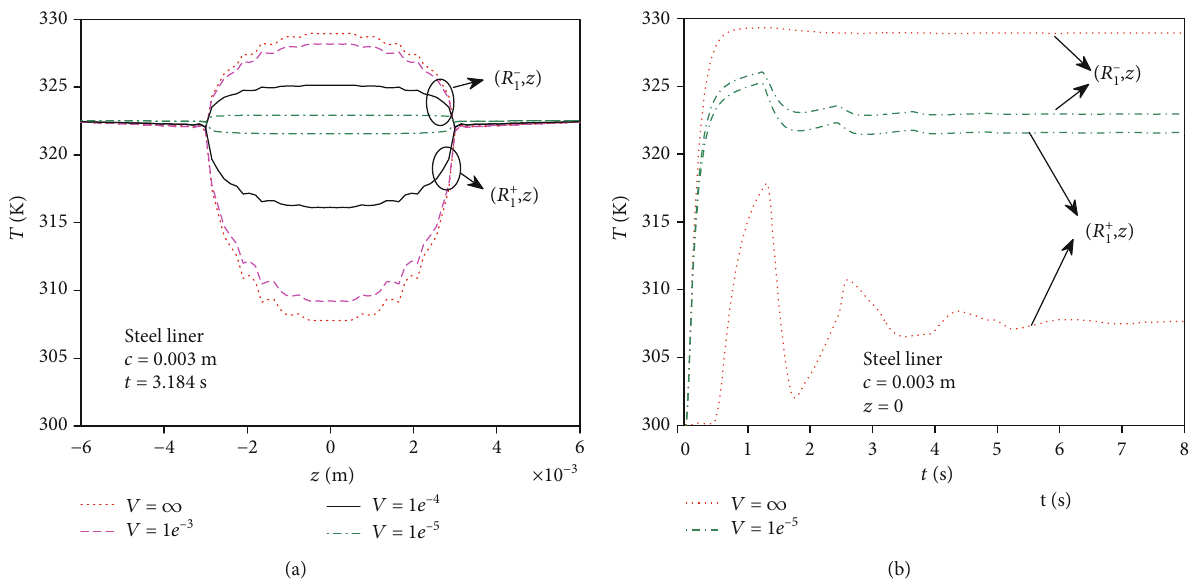
Figure 3: E ff ect of crack resistance on (a) temperature distribution along the interface plane and (b) temperature history at the crack face midpoints.